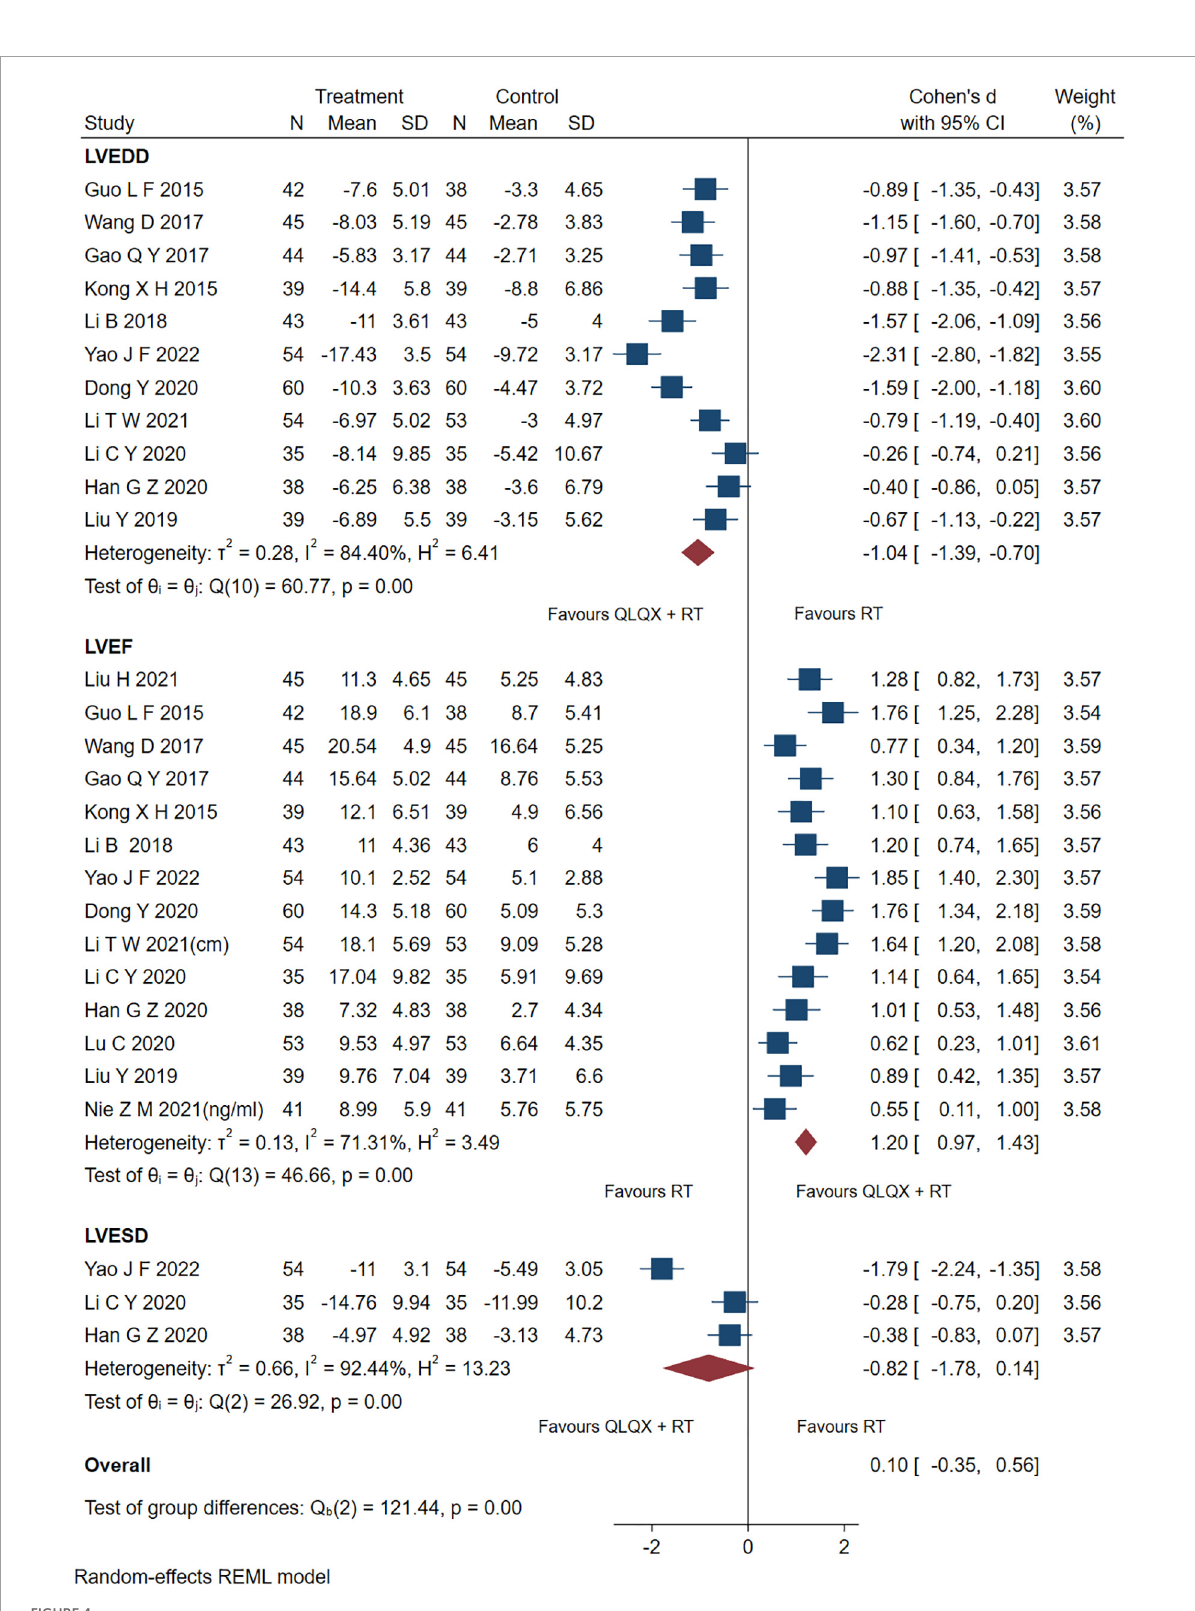
FIGURE4 Forest plot of the cardiac